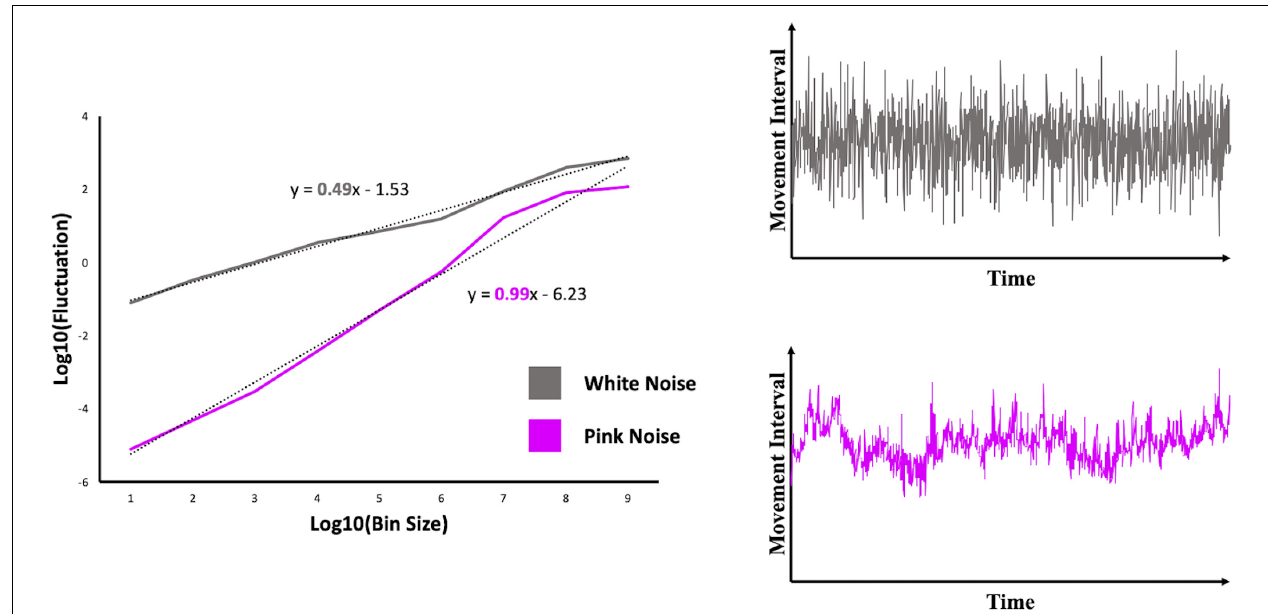
FIGURE 2 | Log-log plots including a scaling relation reflecting simulated time series of white noise (gray line) and pink noise (pink line). The corresponding time series on which the scaling relations are determined, are displayed in the graphs on the right.